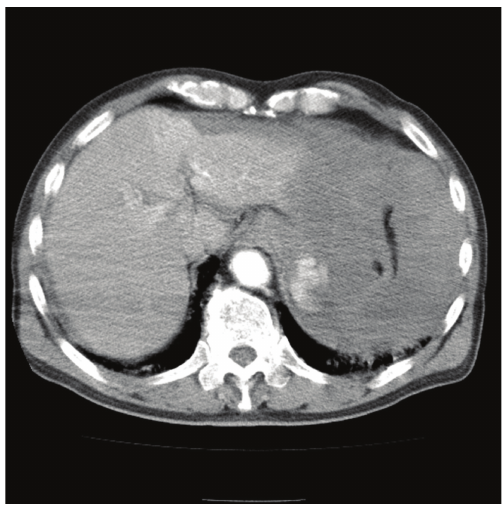
Figure 2: Transverse plane of helical CT of abdomen with IV contrast shows extravasation at splenic hilum and fluid around spleen.